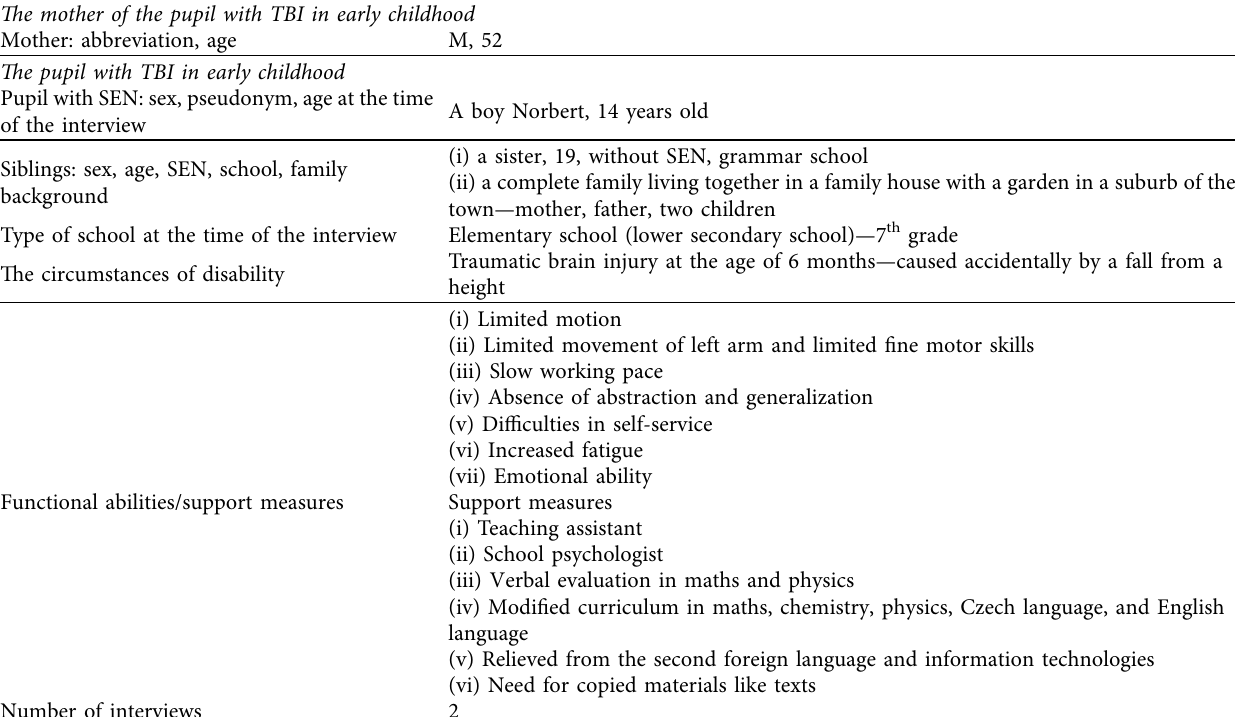
Table 1: The participant’s